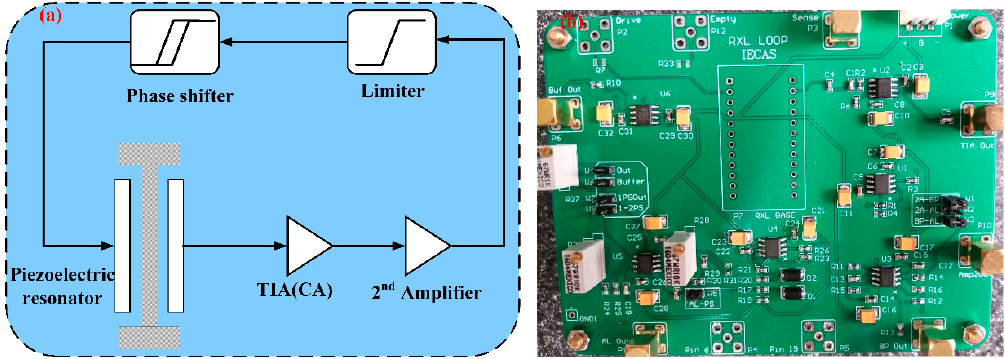
Figure 8. The closed ‐ loop interface circuit of the piezoelectric cantilever resonator for measuring the tip displacement. ( a ) The schematic of interface circuit; ( b ) the actual PCB circuit.